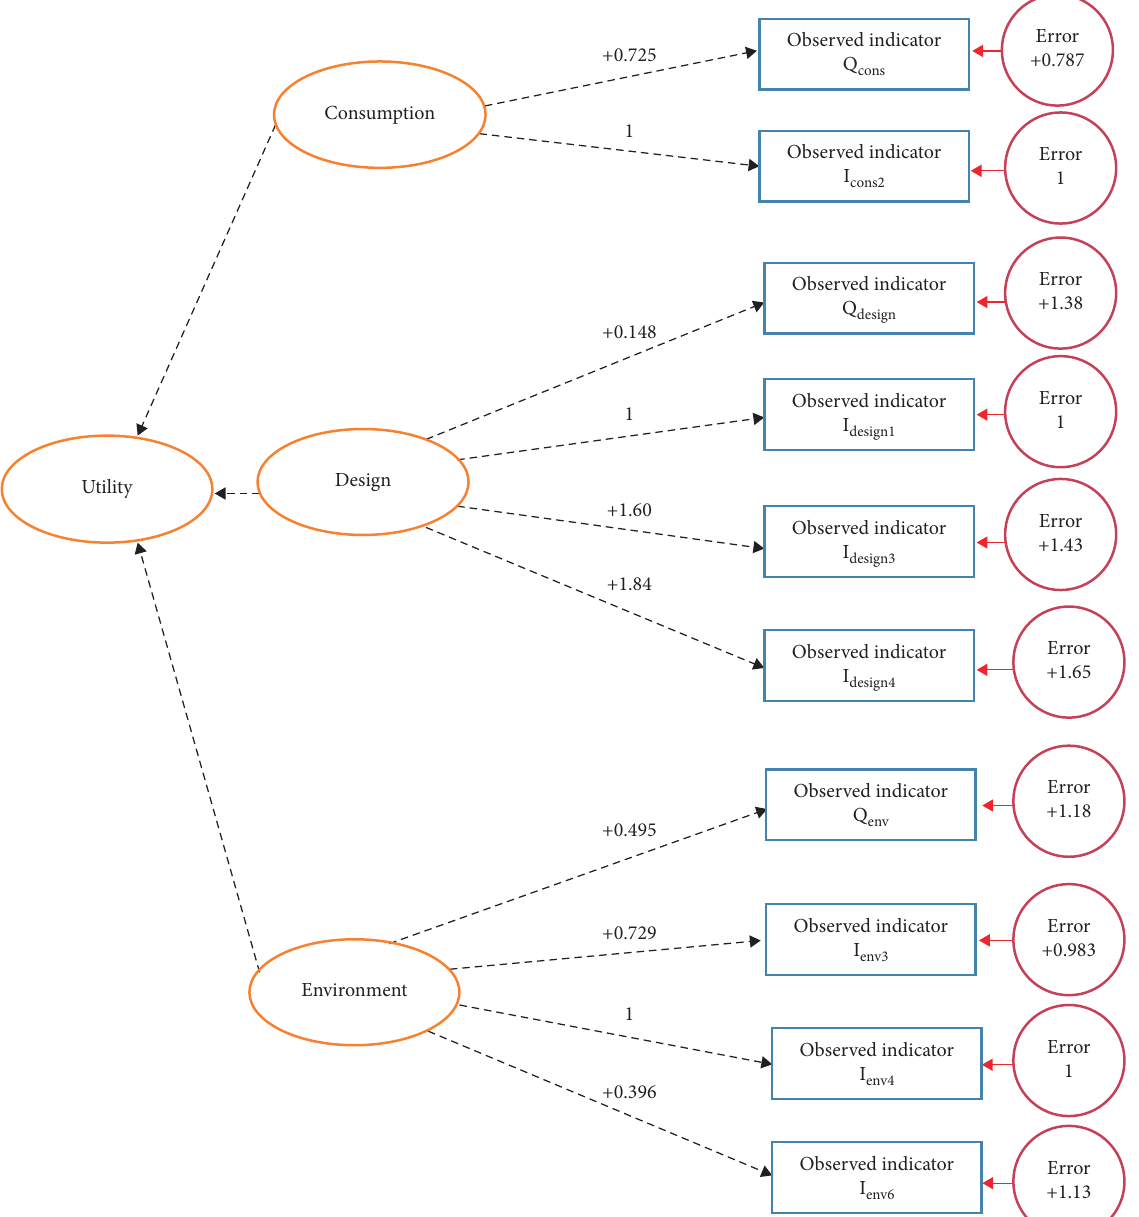
Figure 2: Path diagram of the measurement